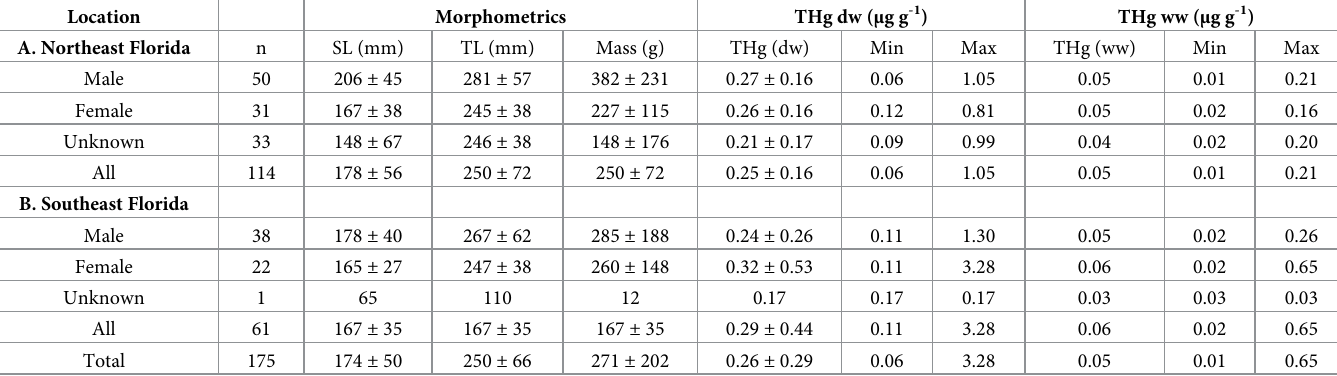
Table 1. Morphometric and THg summary data by location and sex for lionfish in Florida.